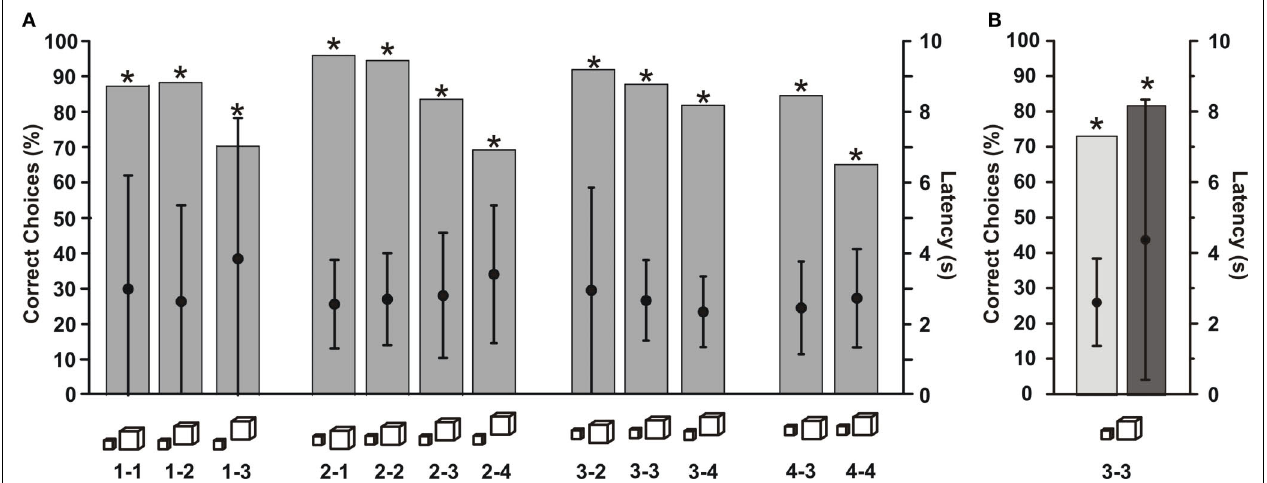
gate towards the edge of the object closest to the gate. Dots within each graph give mean choice latencies with standard deviation (right ordinate). N > 27 test trials per column. (B) Results of control experiments done under dim light conditions (light grey column) and in complete darkness (dark grey column). Both objects were placed 3 cm from the gates. N > 50 test trials per